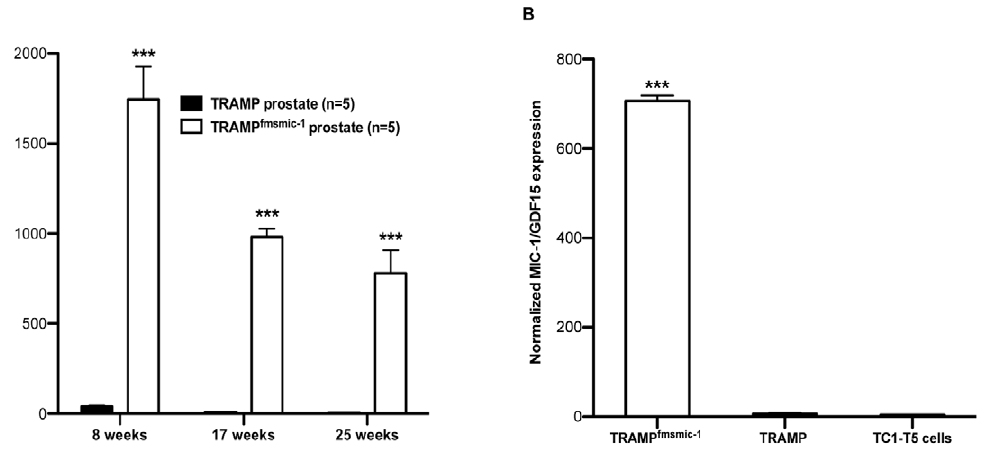
Figure 3. MIC-1/GDF15 expression in TRAMP and TRAMP fmsmic-1 prostate and TC1-T5 cell line. (A) MIC-1/GDF15 expression was quantified by qRT-PCR in the prostate of TRAMP and TRAMP fmsmic-1 mice at 8, 17 and 25 weeks and normalized to B-actin expression as described in material and methods. (B) Relative MIC-1/GDF15 expression was quantified by qRT-PCR in the TC1-T5 cell line (n=3) and compared with TRAMP (n=3) and TRAMP fmsmic-1 (n=3) prostate tumor after normalizing with TBP expression. Values are presented as mean normalized MIC-1/GDF15 expression 6 SEM. p values for the two-tailed unpaired t test are shown as ***p , 0.001.